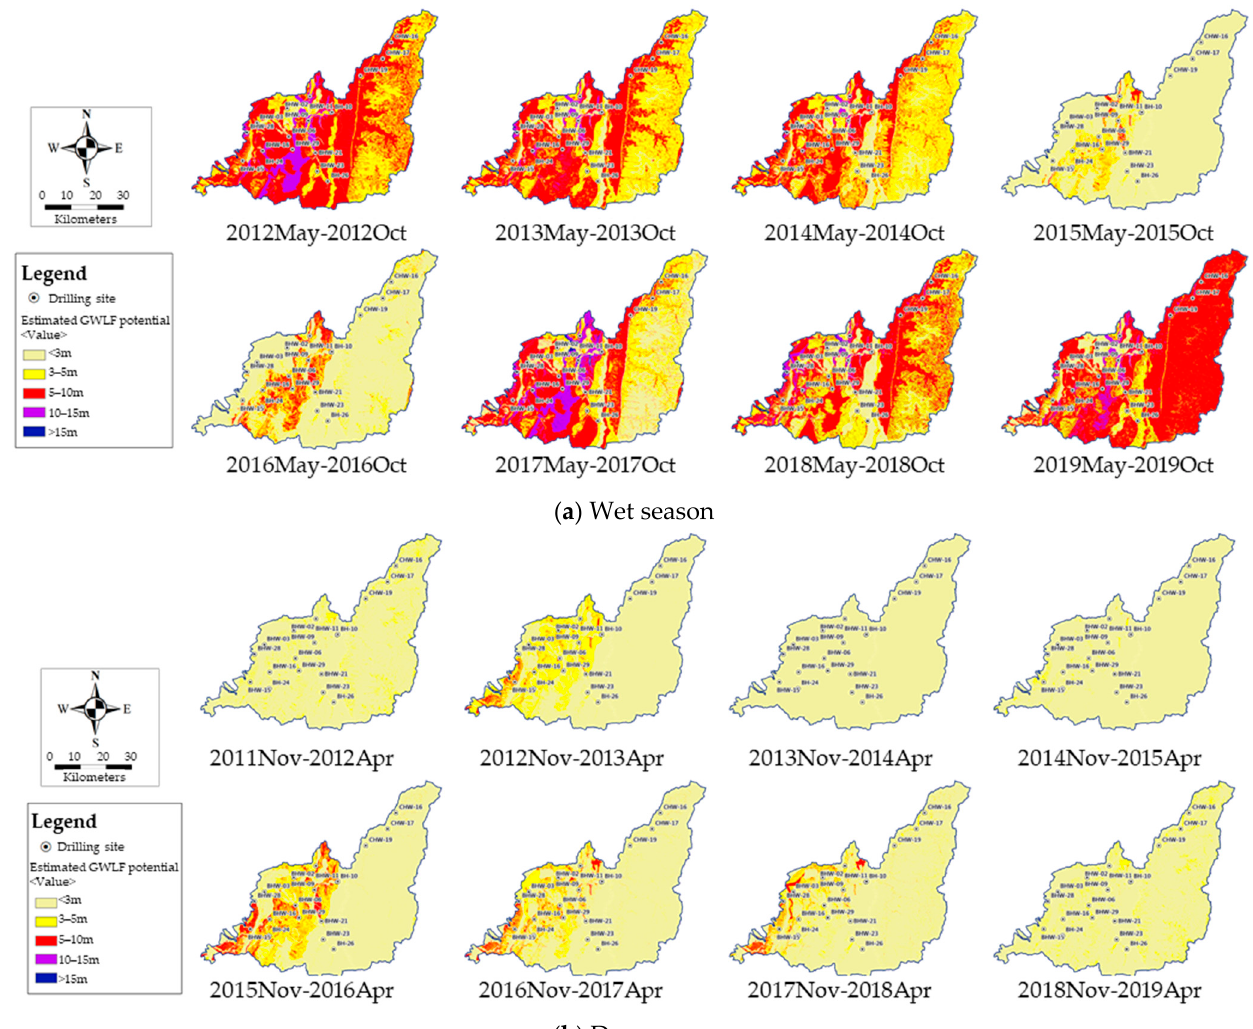
Figure 15. Estimated groundwater level fluctuation potential during 2011–2019 in the wet/dry sea- son. ( a ) Wet season, ( b ) dry season.